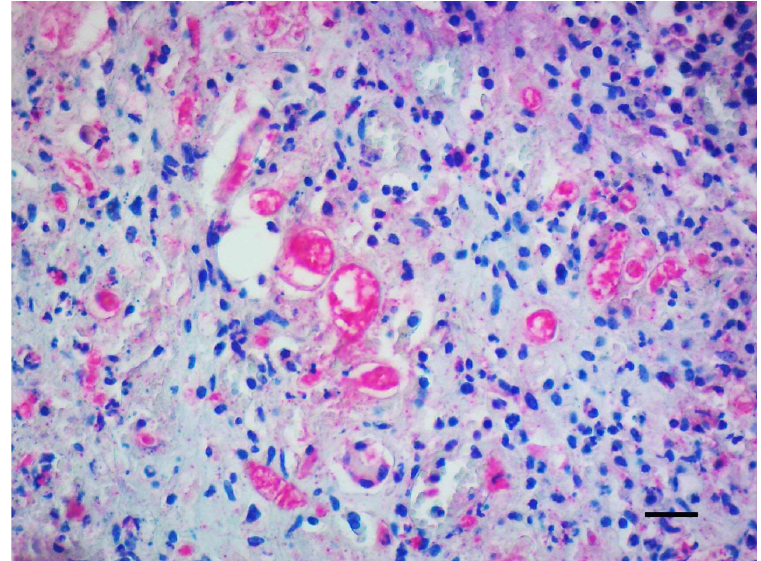
figura 7. Fotomicrografia da lesão rinofaringea em ovino (1PS) com conidiobolomicose. Marcação imunohistoquímica para C. lamprauges . Obj. 40x. Barra, 10 µ